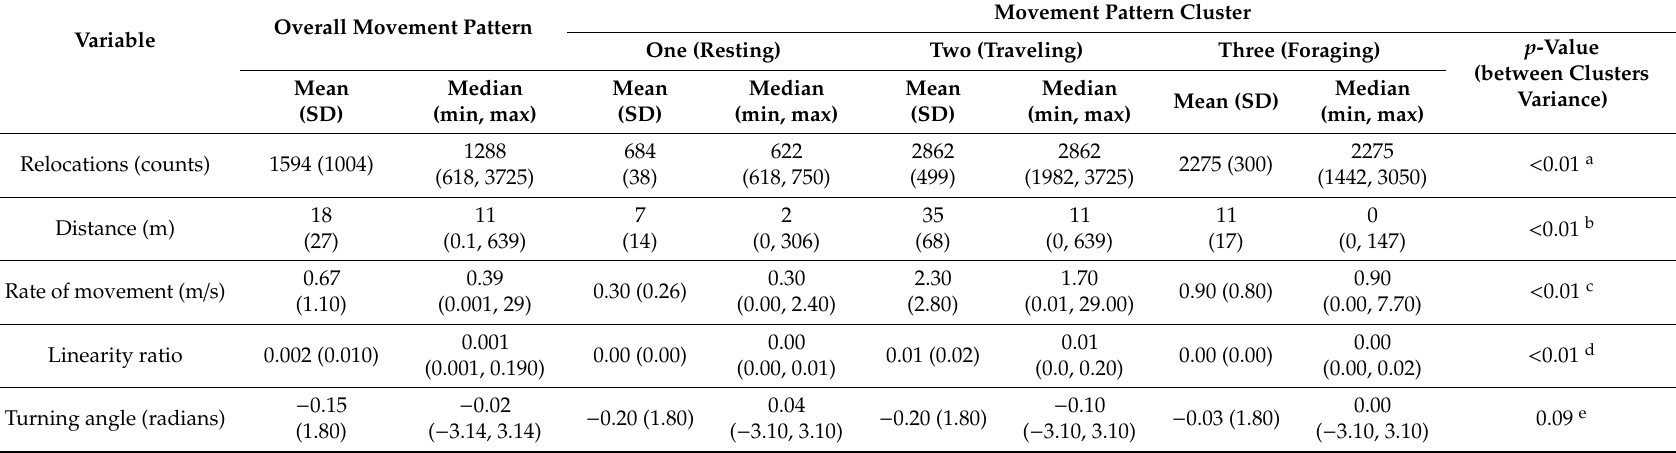
Table 1. Summary of overall and cluster-specific movement pattern data for the 11 calves as obtained from each global positioning system (GPS) logger units.